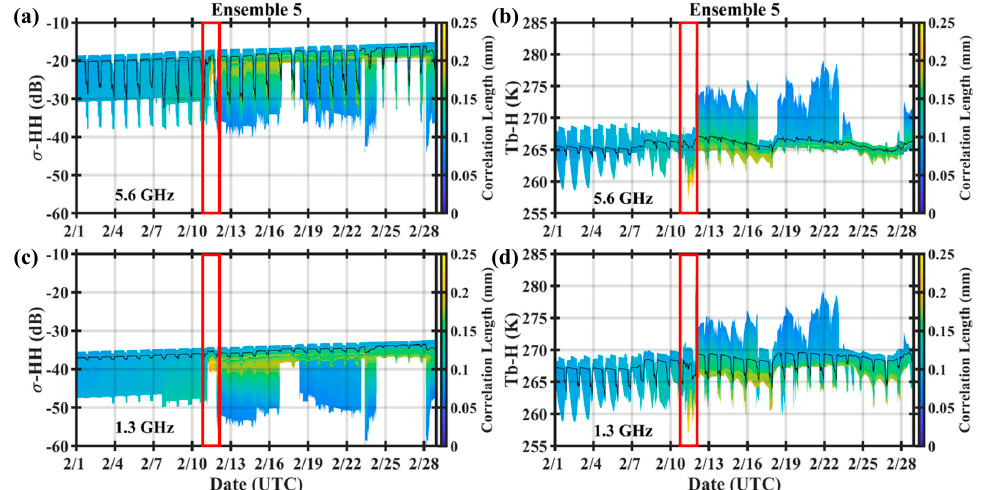
Figure 12. Temporal evolution of Ensemble 5 backscattering coefficients σ -HH and H-pol brightness temperatures at 5.6 GHz ( a , b ) and 1.3 GHz ( c , d ) contoured by correlation length of the snowpack top layer. The black line is the Ensemble 5 mean. The red box marks the overnight period from 2/10/2017 to 2/11/2017, followed by daytime hours. UTC = Mountain Standard Time + 7.